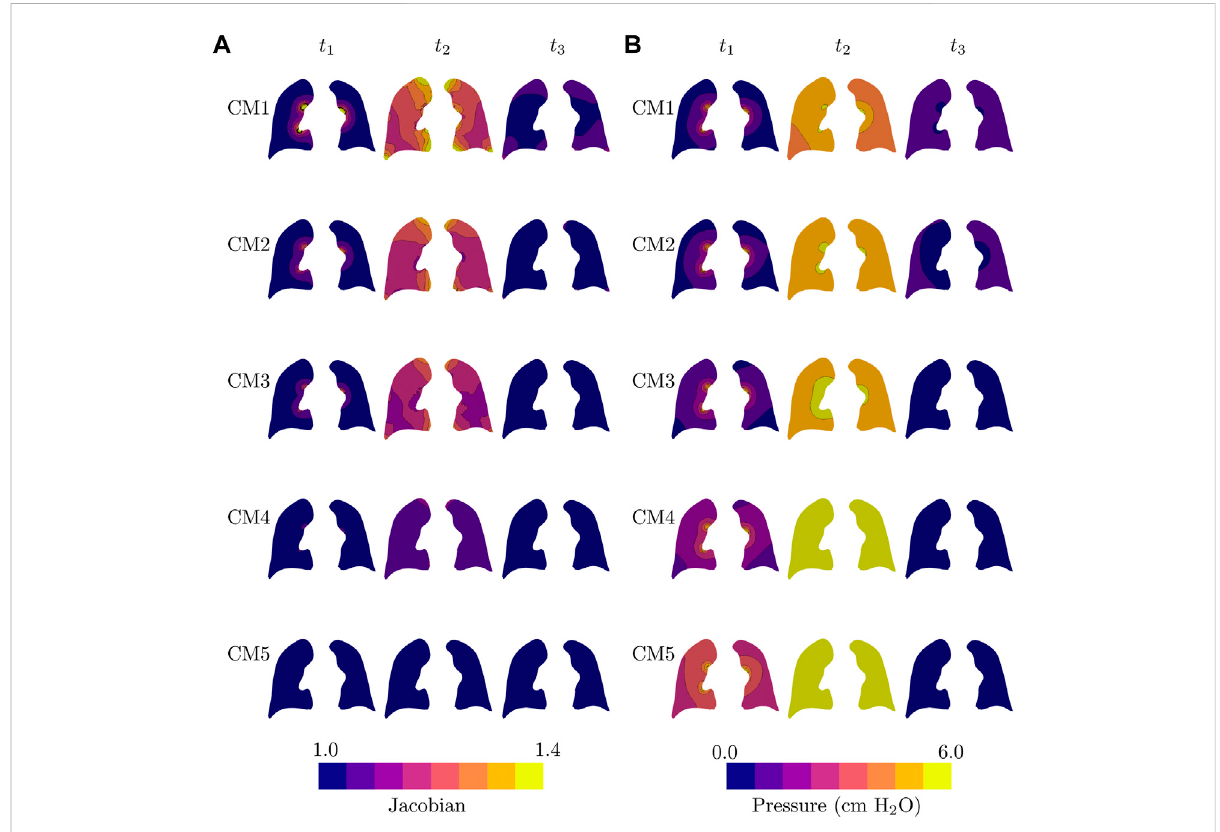
FIGURE 5 Temporal evolution of all lung models during one respiratory cycle of pressure-controlled mechanical ventilation: (A) jacobian fi eld, and (B) alveolar pressure fi eld. Fields are plotted in the current con fi